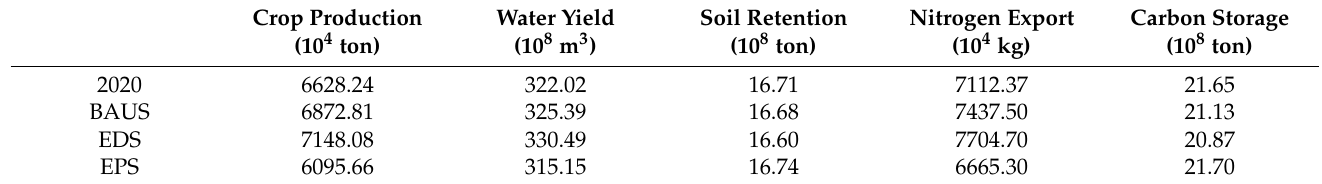
Table 2. Total amount of each ecosystem service in 2020 and under three scenarios in 2030. Crop